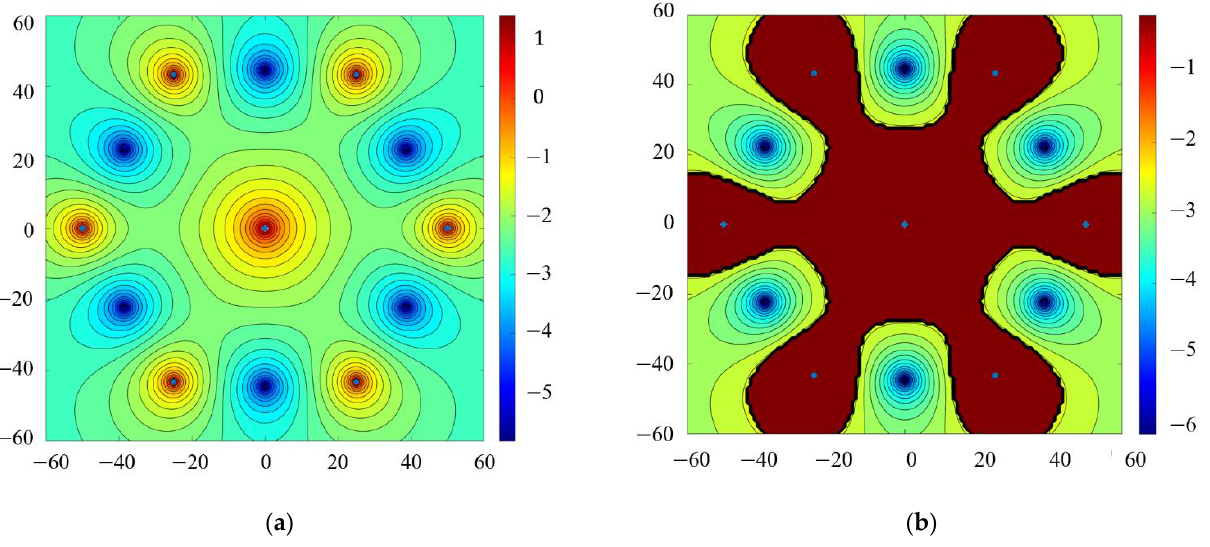
Figure 1. The pressure gradient distribution and the swept area, 𝛽 B = 𝛽 C = 𝛽 D = 𝛽 E = 𝛽 F = 1,𝛽 Z = 2 . ( a ) Pressure gradient; ( b ) swept area.